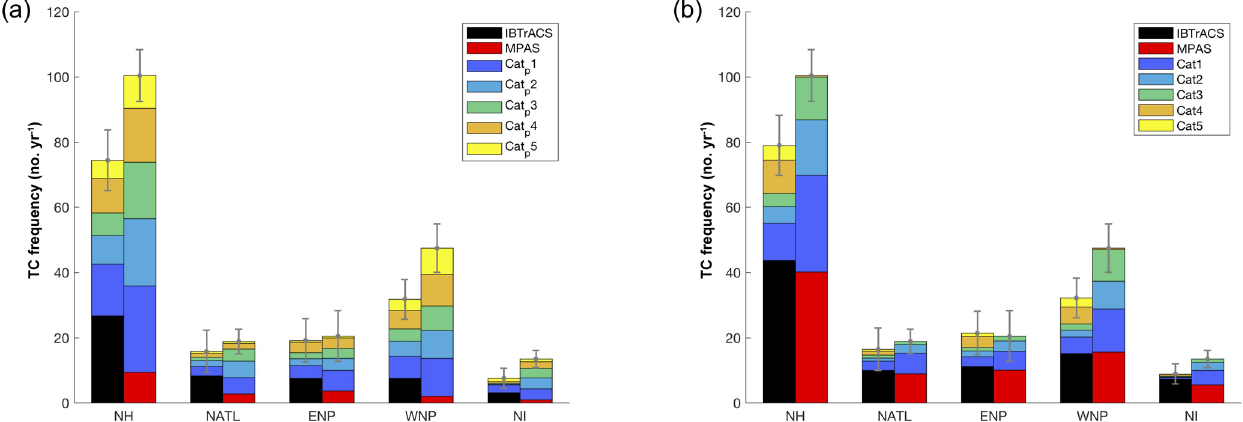
Figure 8. Average number of TCs over the 10 simulation years for the Northern Hemisphere and each Northern Hemisphere basin. Columns are colored by intensity categories based on (a) minimum lifetime SLP and (b) maximum lifetime 10m wind speed. The bottom color represents intensities of tropical storm strength or less for IBTrACS and MPAS-A in the first and second columns, respectively. Categories 1– 5 are shaded for both datasets according to the legend. The error bars indicate the interannual standard deviation. The number of TCs for IBTrACS varies based on strength metric due to the lack of SLP records for a select number of